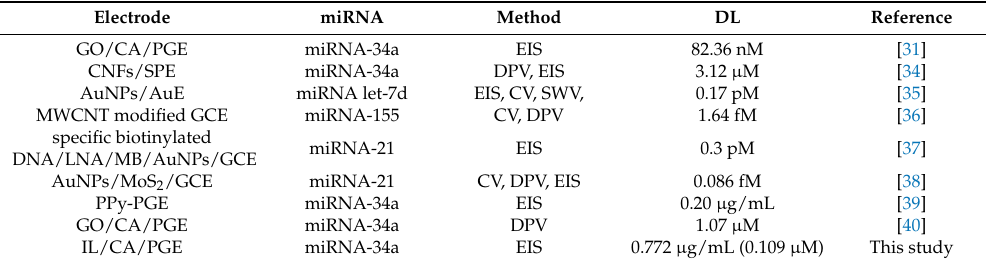
Table 1. Recent studies developed for miRNA detection compared to the present study. Abbreviations: Electrodes: PGE: pencil graphite electrode, SPE: screen printed electrode, GCE: glassy carbon electrode,